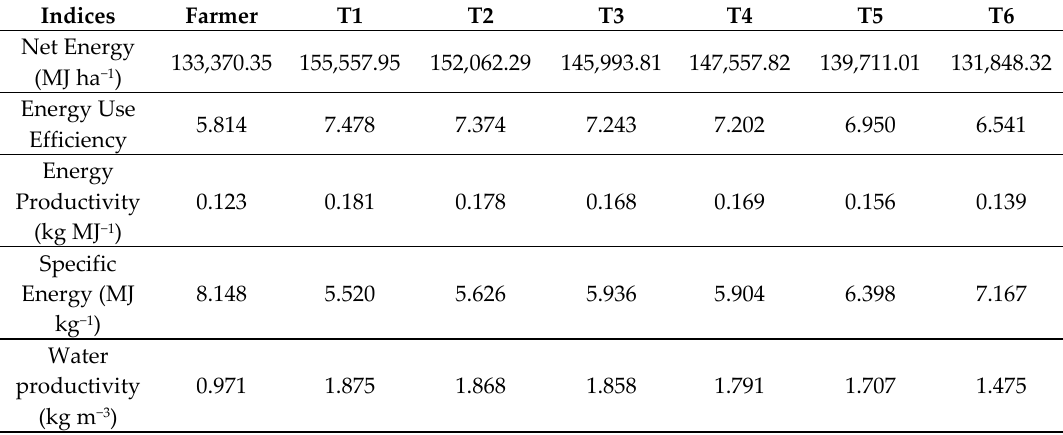
Table 4. Analysis of energy indices in wheat